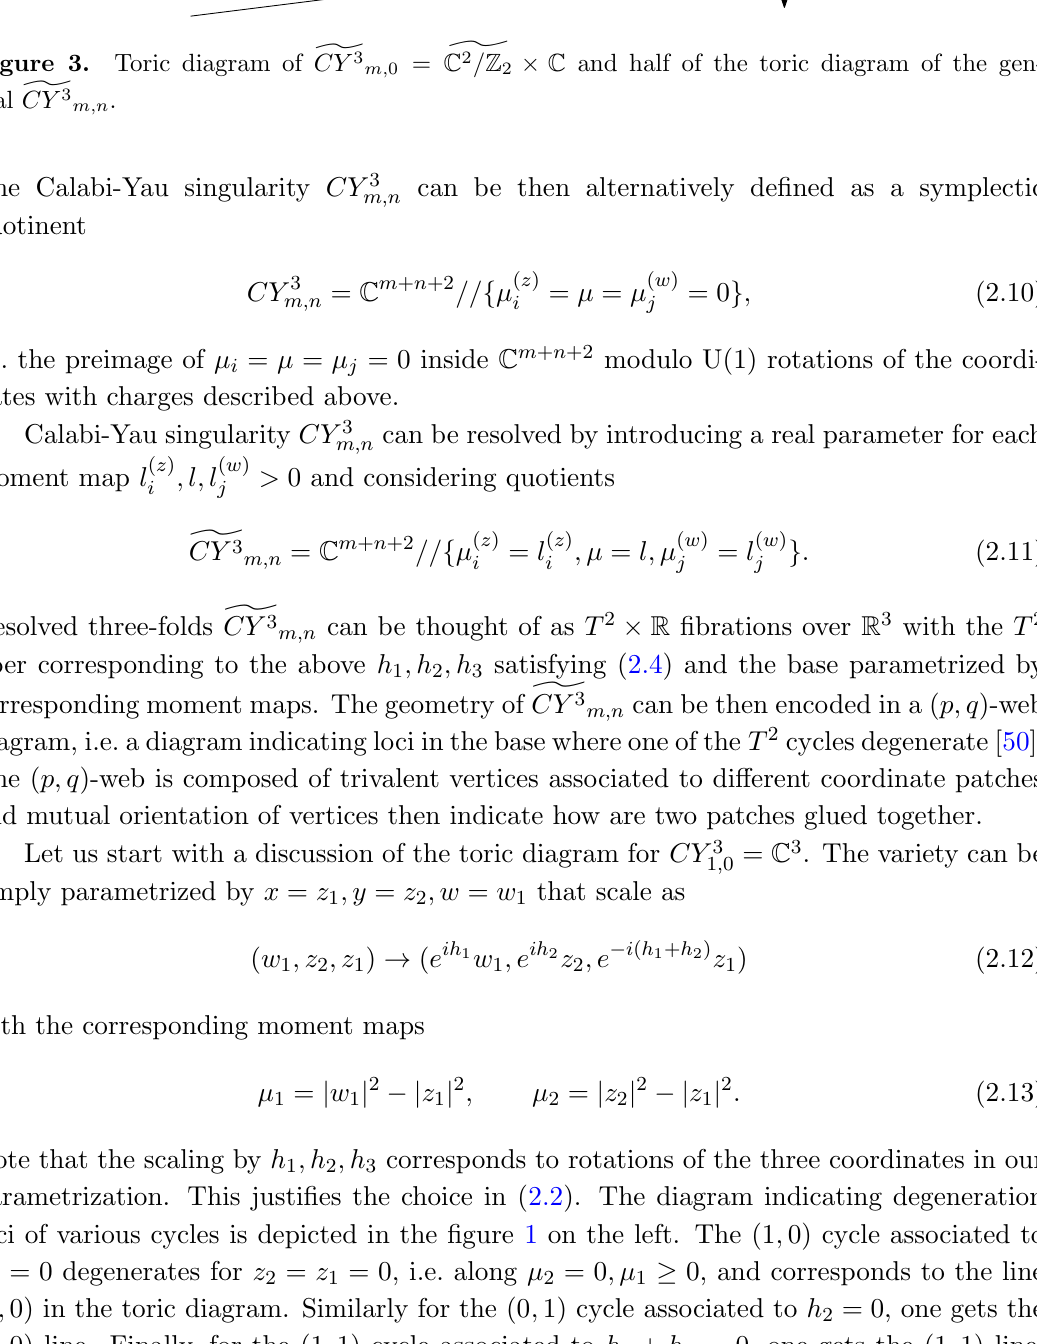
^C ] C and half of the toric diagram of the gen- 2 = Z CY 3 m; 0 = 2 (cid:2)